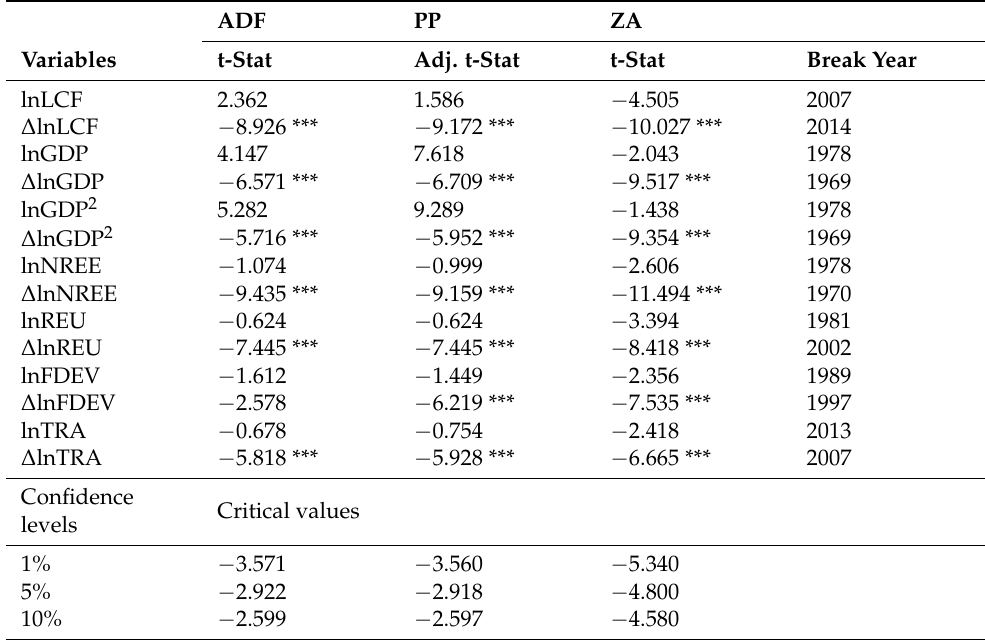
Table 3. Unit root tests results.